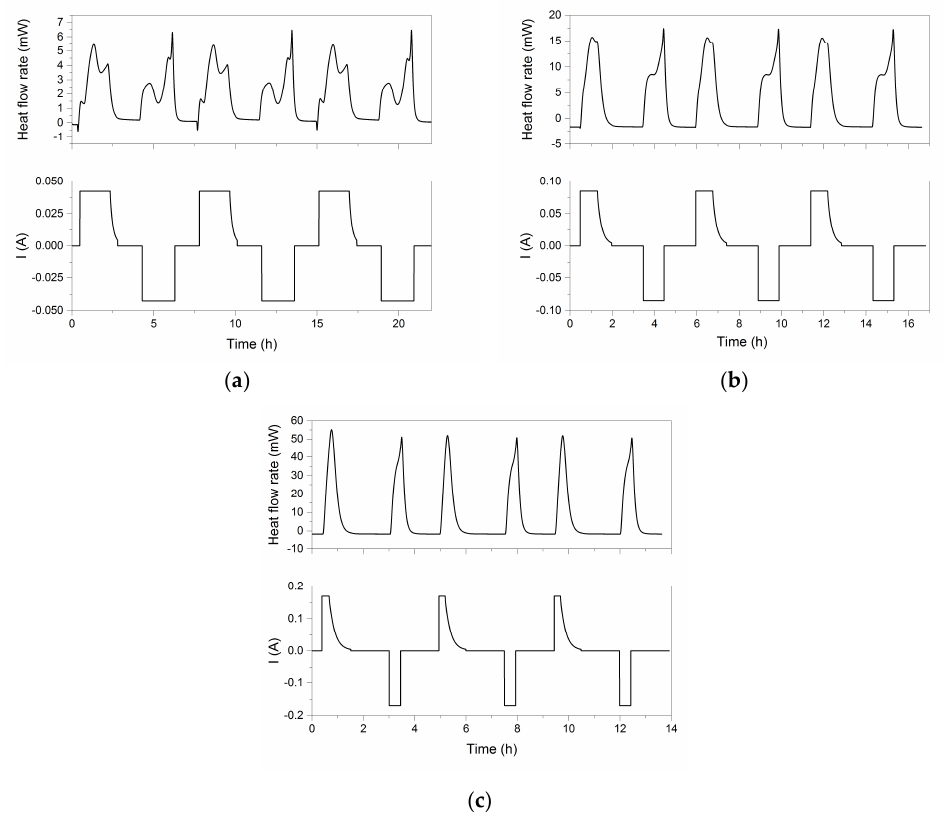
Figure 8. Heat flow rates measured by C80 calorimeter versus time at 30 °C for different applied current rates: ( a ) 0.5 C, ( b ) 1 C, and ( c ) 2 C.